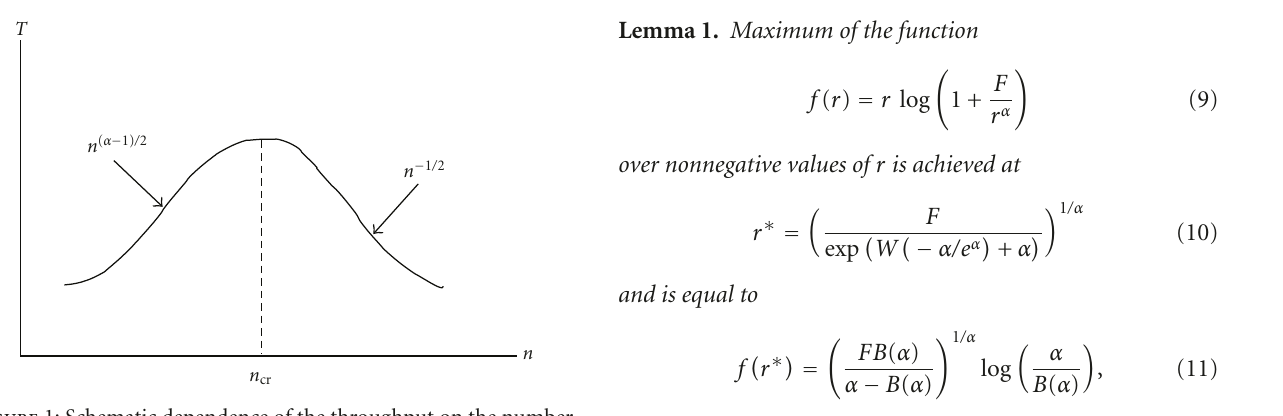
Figure 1: Schematic dependence of the throughput on the number of nodes in case of constant network area and starting node density below